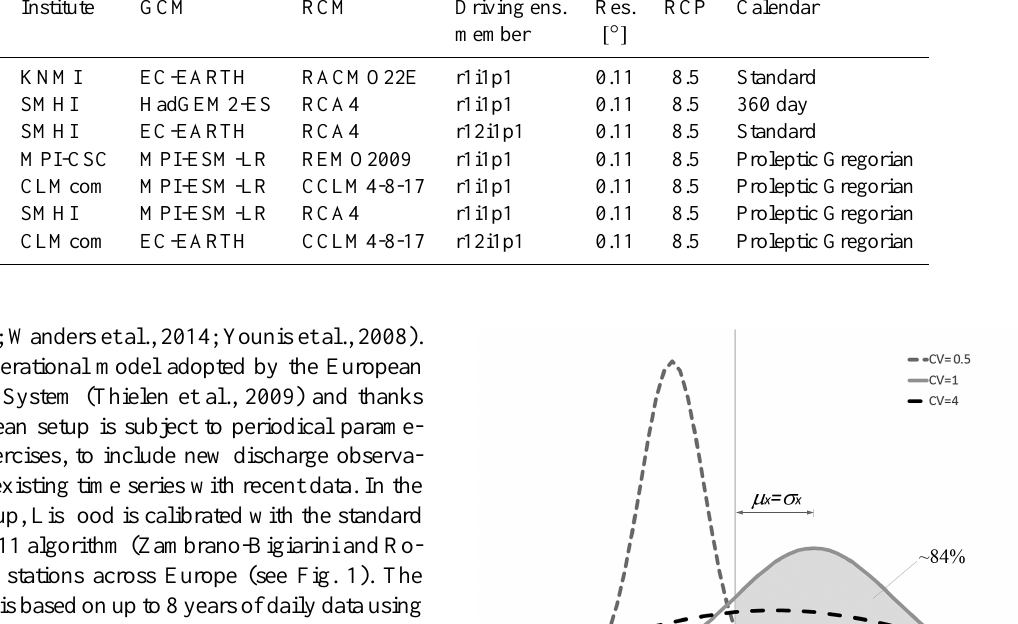
Table 1. EURO-CORDEX climate scenarios used in this study. Institute GCM RCM Driving ens. Res. RCP